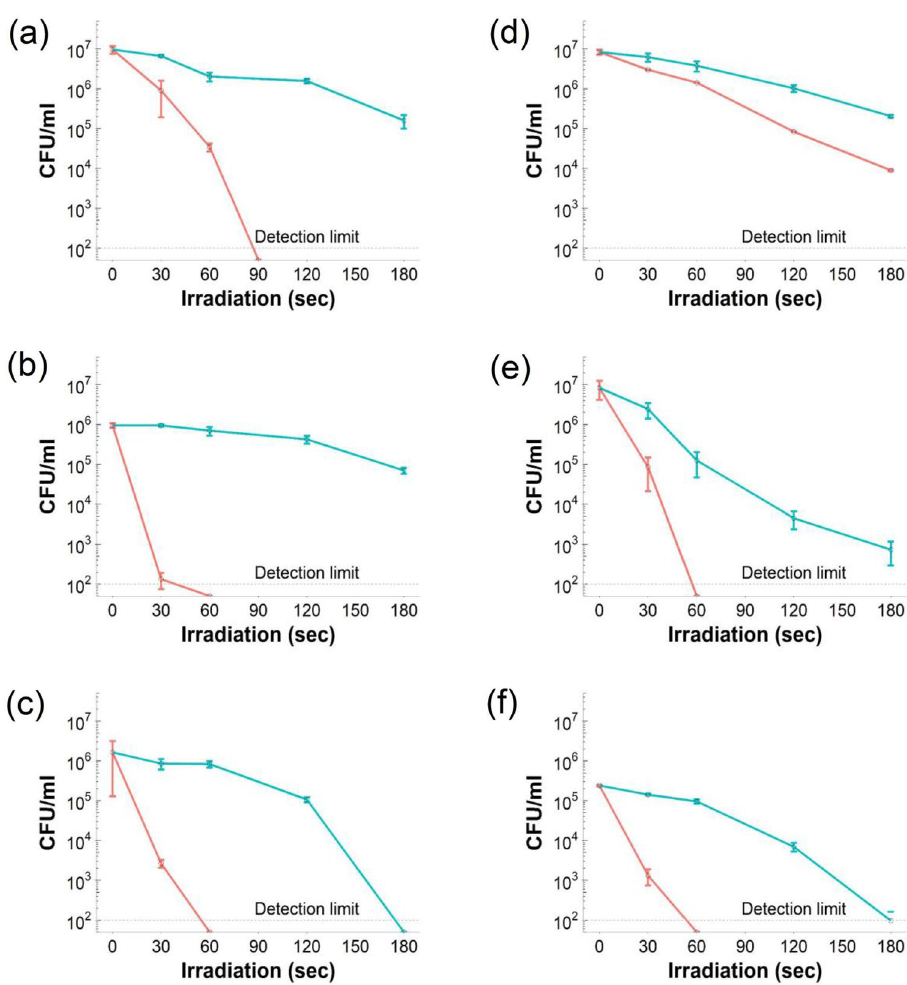
Figure 5. Antimicrobial activity of TBO (blue circles) and A3-e1-TBO (orange circles) against ( a ) E. coli, ( b ) P. aeruginosa , ( c ) A. baumannii , ( d ) MRSA , ( e ) S. epidermidis and ( f ) S. pyogenes (mean ± SD, n =